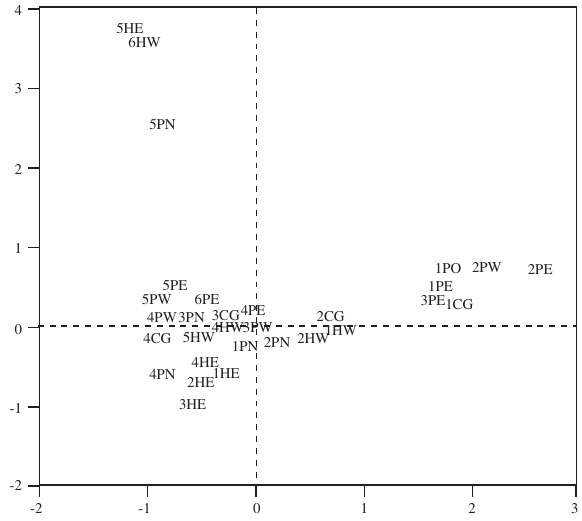
F IG . 6. – Sample representation in the two first axes derived from a factorial correspondence analysis. Sample codes correspond to those appearing in Table 1.